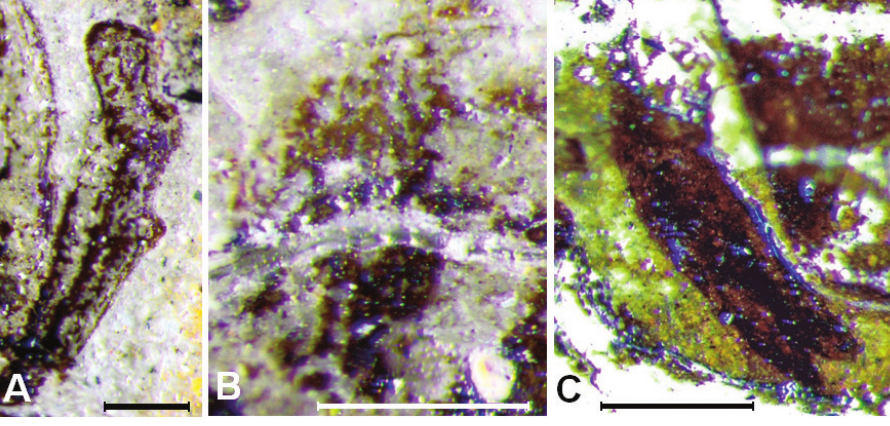
Figure 4. Ceafornotensis archratiras gen. and sp. n.: ( A, B, C ) holotype BP/2/18654, characters enlarged. Micrographs of: A right protibia B left mandible C aedeagus. Scale bar: 0.5